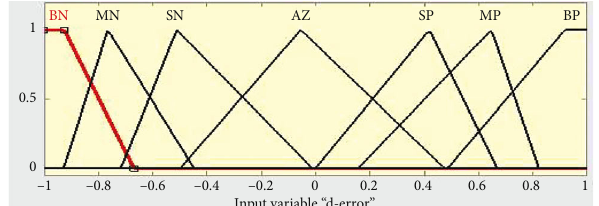
Figure 10: Tuned input membership function for change of current error.